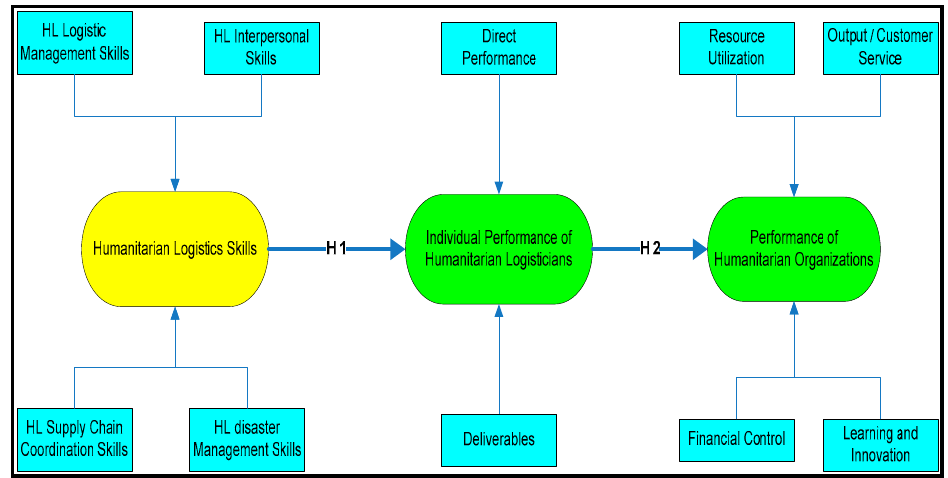
Figure 2. Conceptual model. H 1 : HL skills influence the performance of HL practitioners; H 2 : Performance of HL practitioners increases the performance of humanitarian organisations.